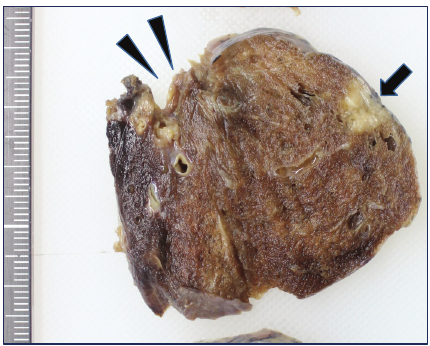
Figure 1: The tumor (arrow) measuring 13 mm is about 3 cm away from the surgical margin (arrowhead).